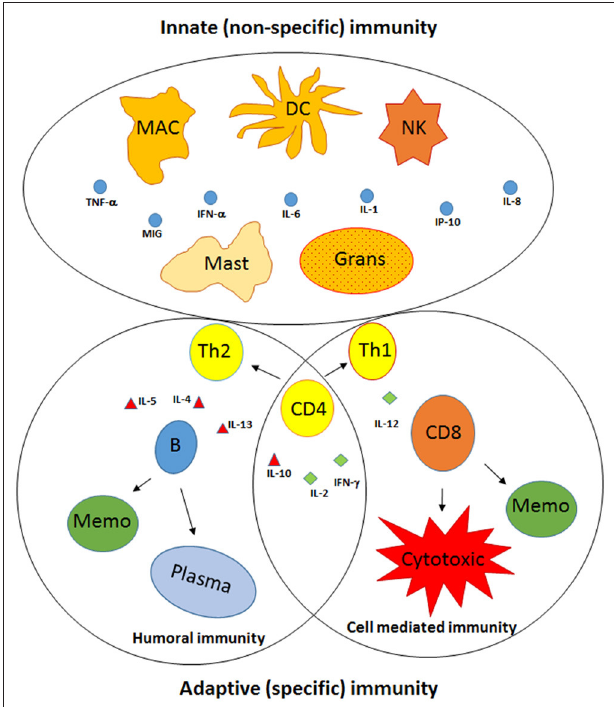
FIGURE 2 | Components of the innate and adaptive immunity. The immune system is broadly categorized into innate and adaptive immune components. Innate immunity is recognized by cellular components, including natural killer (NK), dendritic cells (DC), macrophages (MAC), mast cells, and granulocytes (Grans), whereas adaptive immunity is designated by B lymphocytes and T lymphocytes. Following activation, the components of both branches act together and in parallel with regulatory soluble cytokines (IL-1, IL-6, IL-12, IL-10, IL-4) and chemokines (IL-8, IP-10, and MIG). Subsequently, CD4 + T lymphocytes become activated and differentiate into T helper (Th)-1 and Th-2 cells, leading to the activation and differentiation of T lymphocytes into cytotoxic CD8 + T cells and memory cells (Memo), while the B lymphocytes differentiate into plasma cells, which are antibody-specific secreted cells, and Memo,